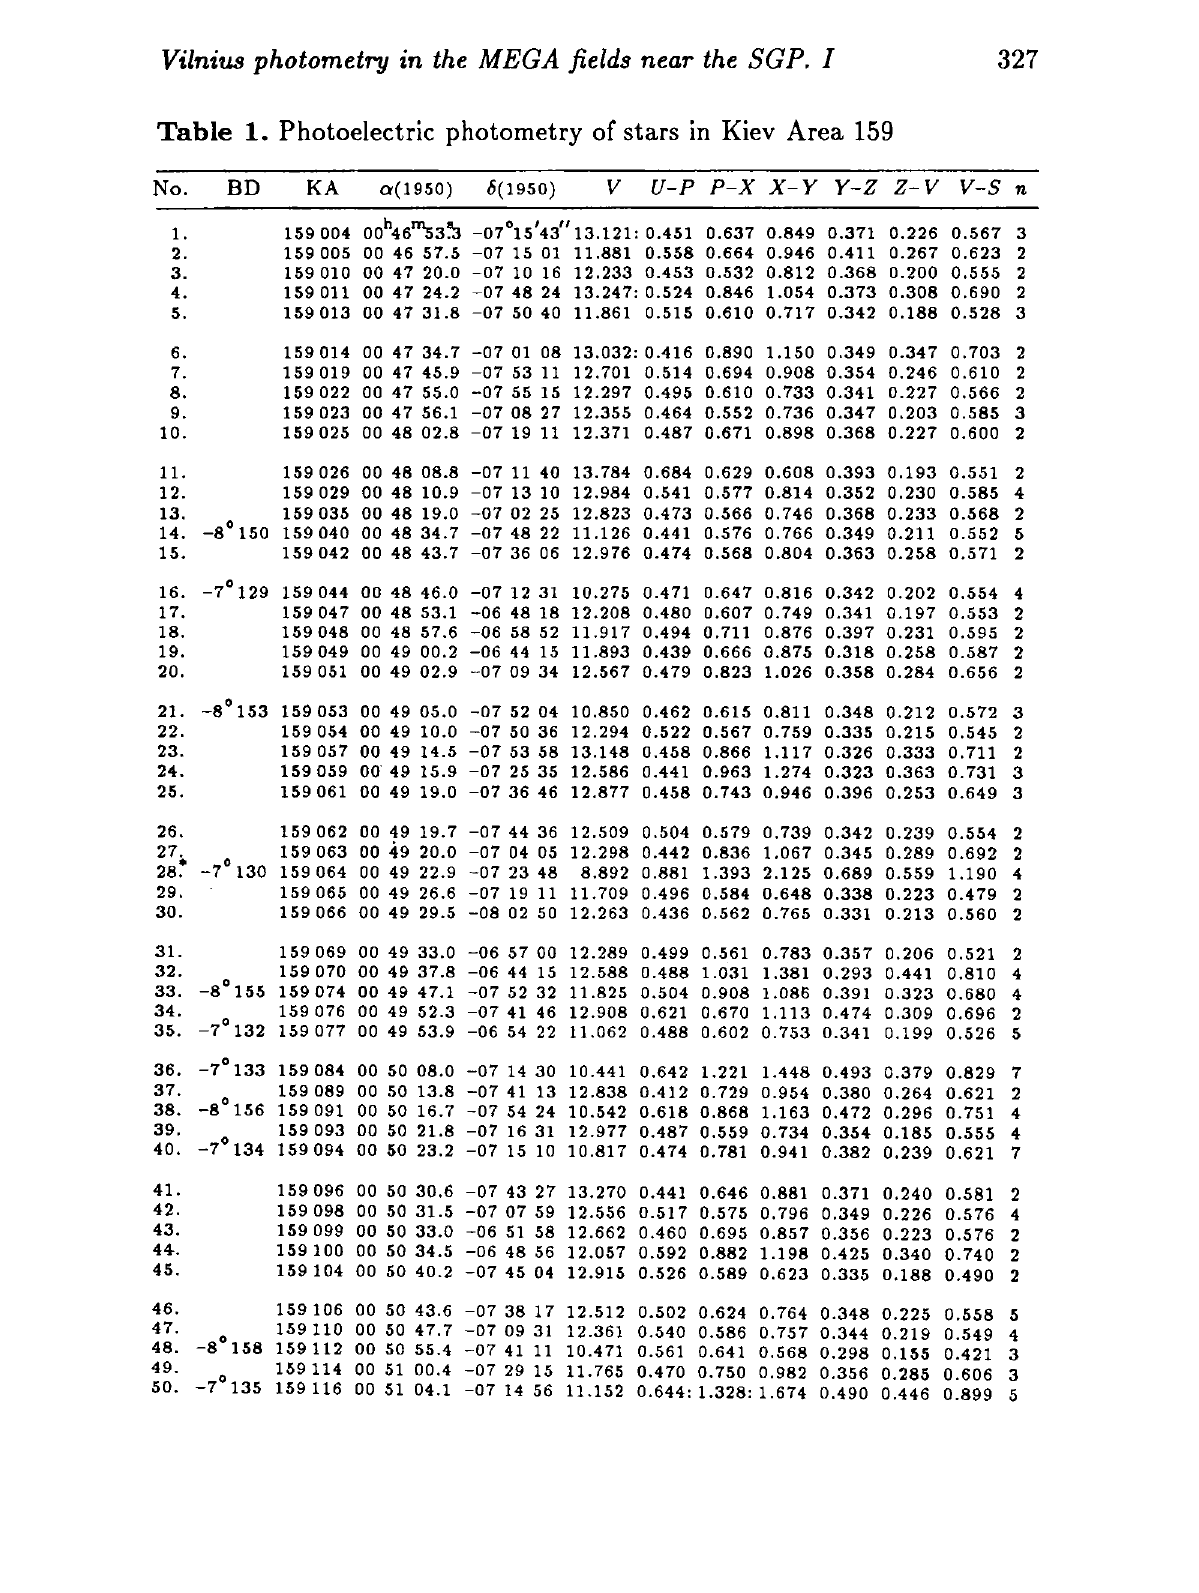
Table 1. Photoelectric photometry of stars in Kiev Area